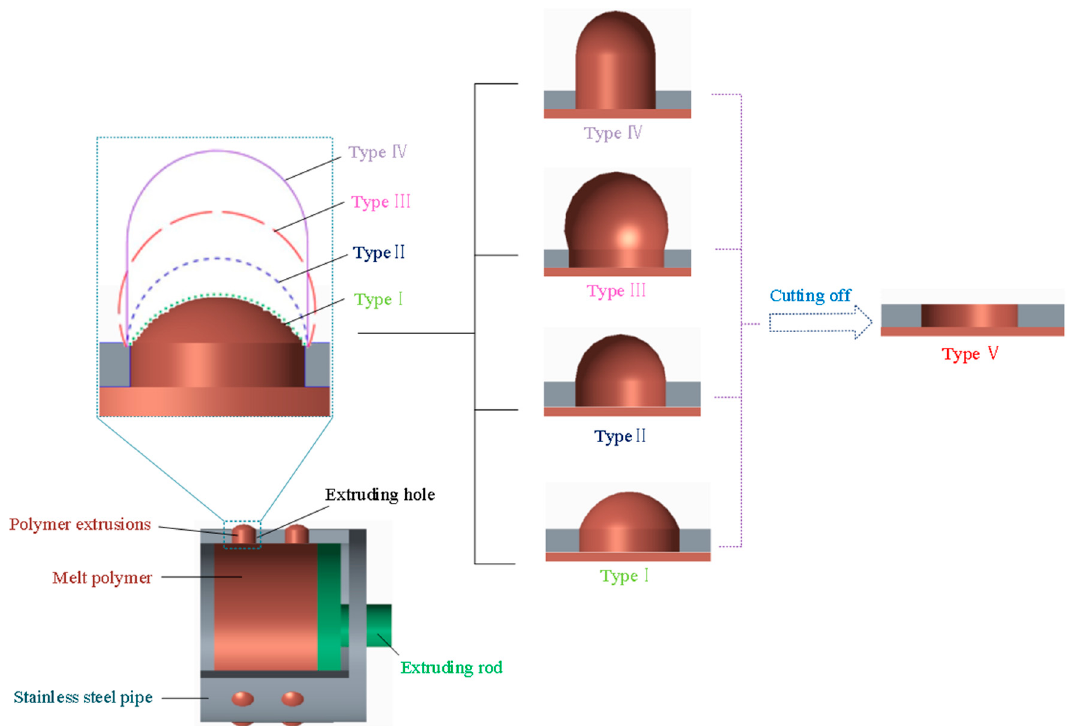
Figure 1. Schematic diagram of preparation of the versatile polymer patterns for electroforming mandrel by extrusion molding process.